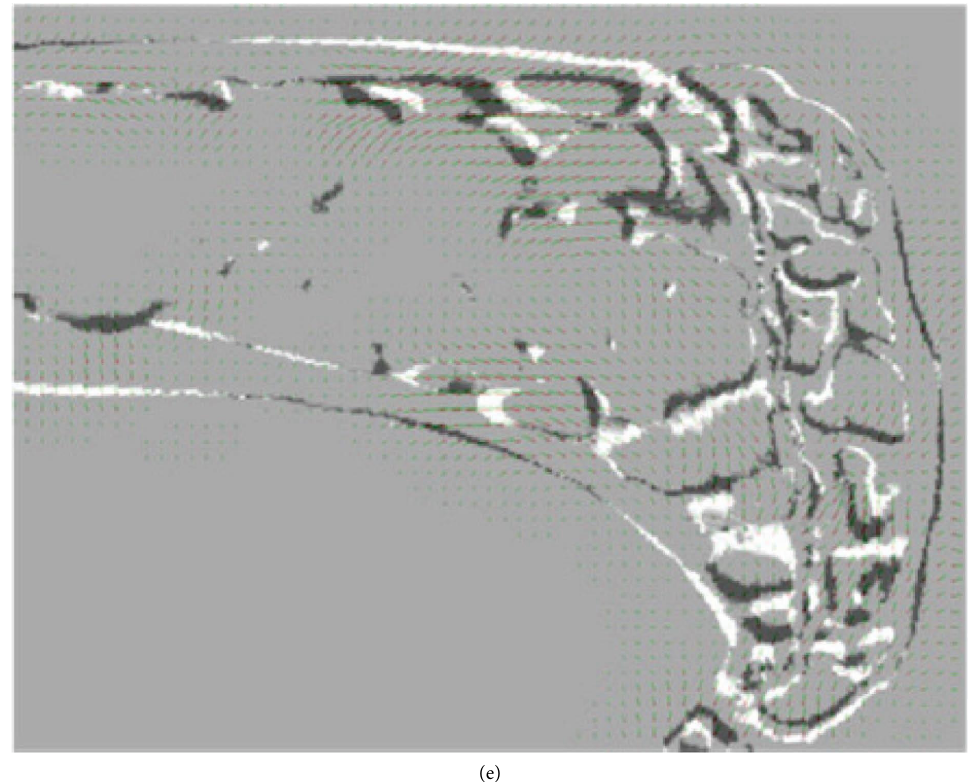
Figure 6: Comparison of the results achieved by SegReg and intensity-based registration for mouse tibia tissue [35]. Stained histological images (von Kossa staining) (a) and CT-plane (b) of mouse bone tibia were matched using SegReg. For this example, both afne and elastic registration techniques were applied. (c) Te outcome of the afne registration approach. (d) Te result of elastic registration. Te overall diference was portrayed in (e) with the corresponding diference in the registration vector feld superimposed. Reprinted by permission from Informa UK Ltd: Taylor and Francis online computer methods in biomechanics and biomedical engineering, 18 :15, 1658–1673, histology to μ CTregistration of 2D histological sections with 3D micro-CTdatasets from small animal vertebrae and tibiae, Oleg Museyko, Robert Percy Marshall, Jing Lu, Andreas Hess, Georg Schett, Michael Amling, Willi A. Kalender, and Klaus Engelke, Copyright© 2014 Informa UK